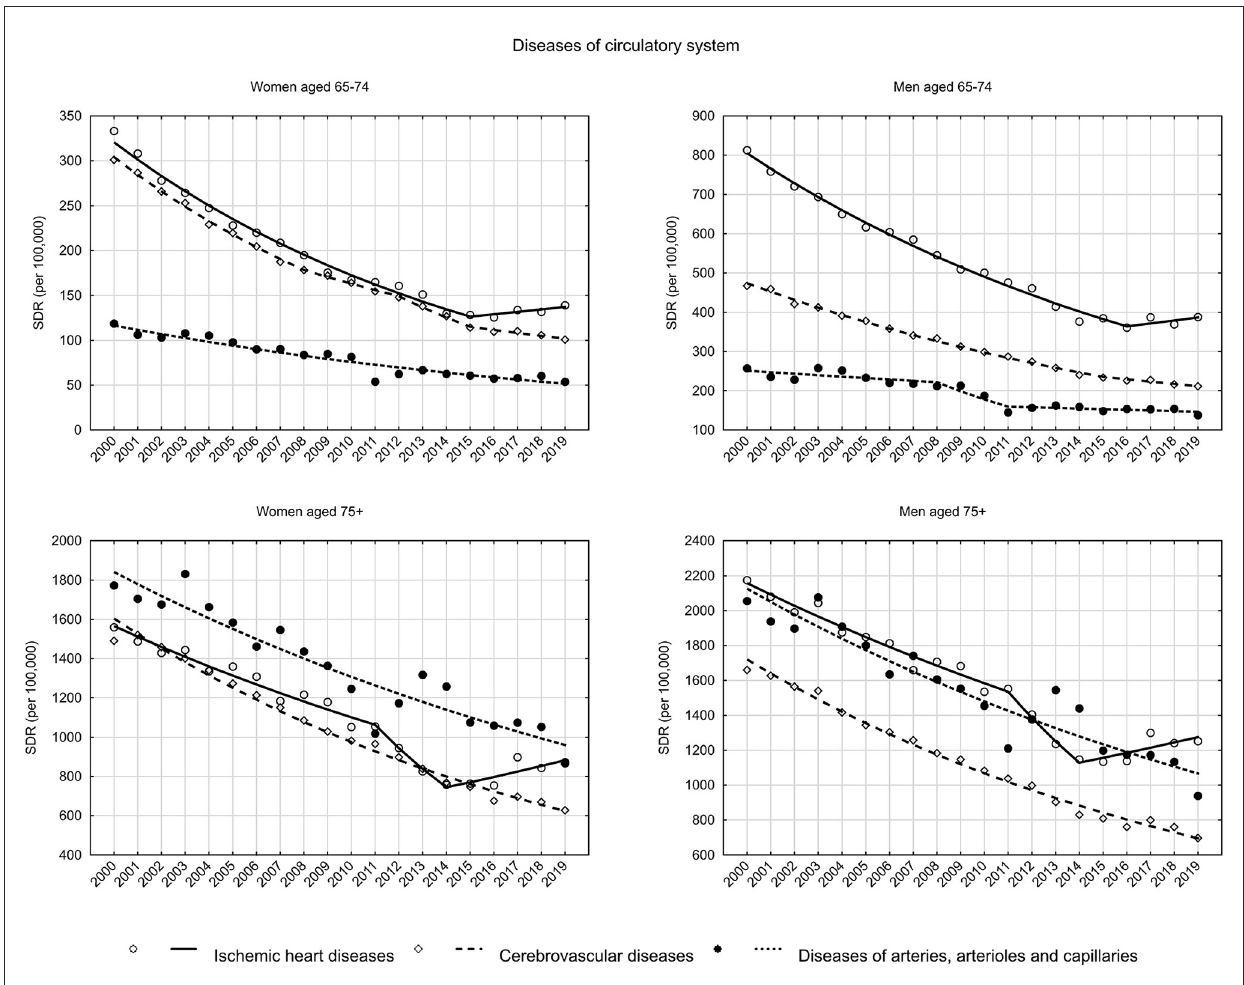
FIGURE2 SDR trends in the Polish population aged 65–74 years and 75 years and older due to diseases of the circulatory system in the years